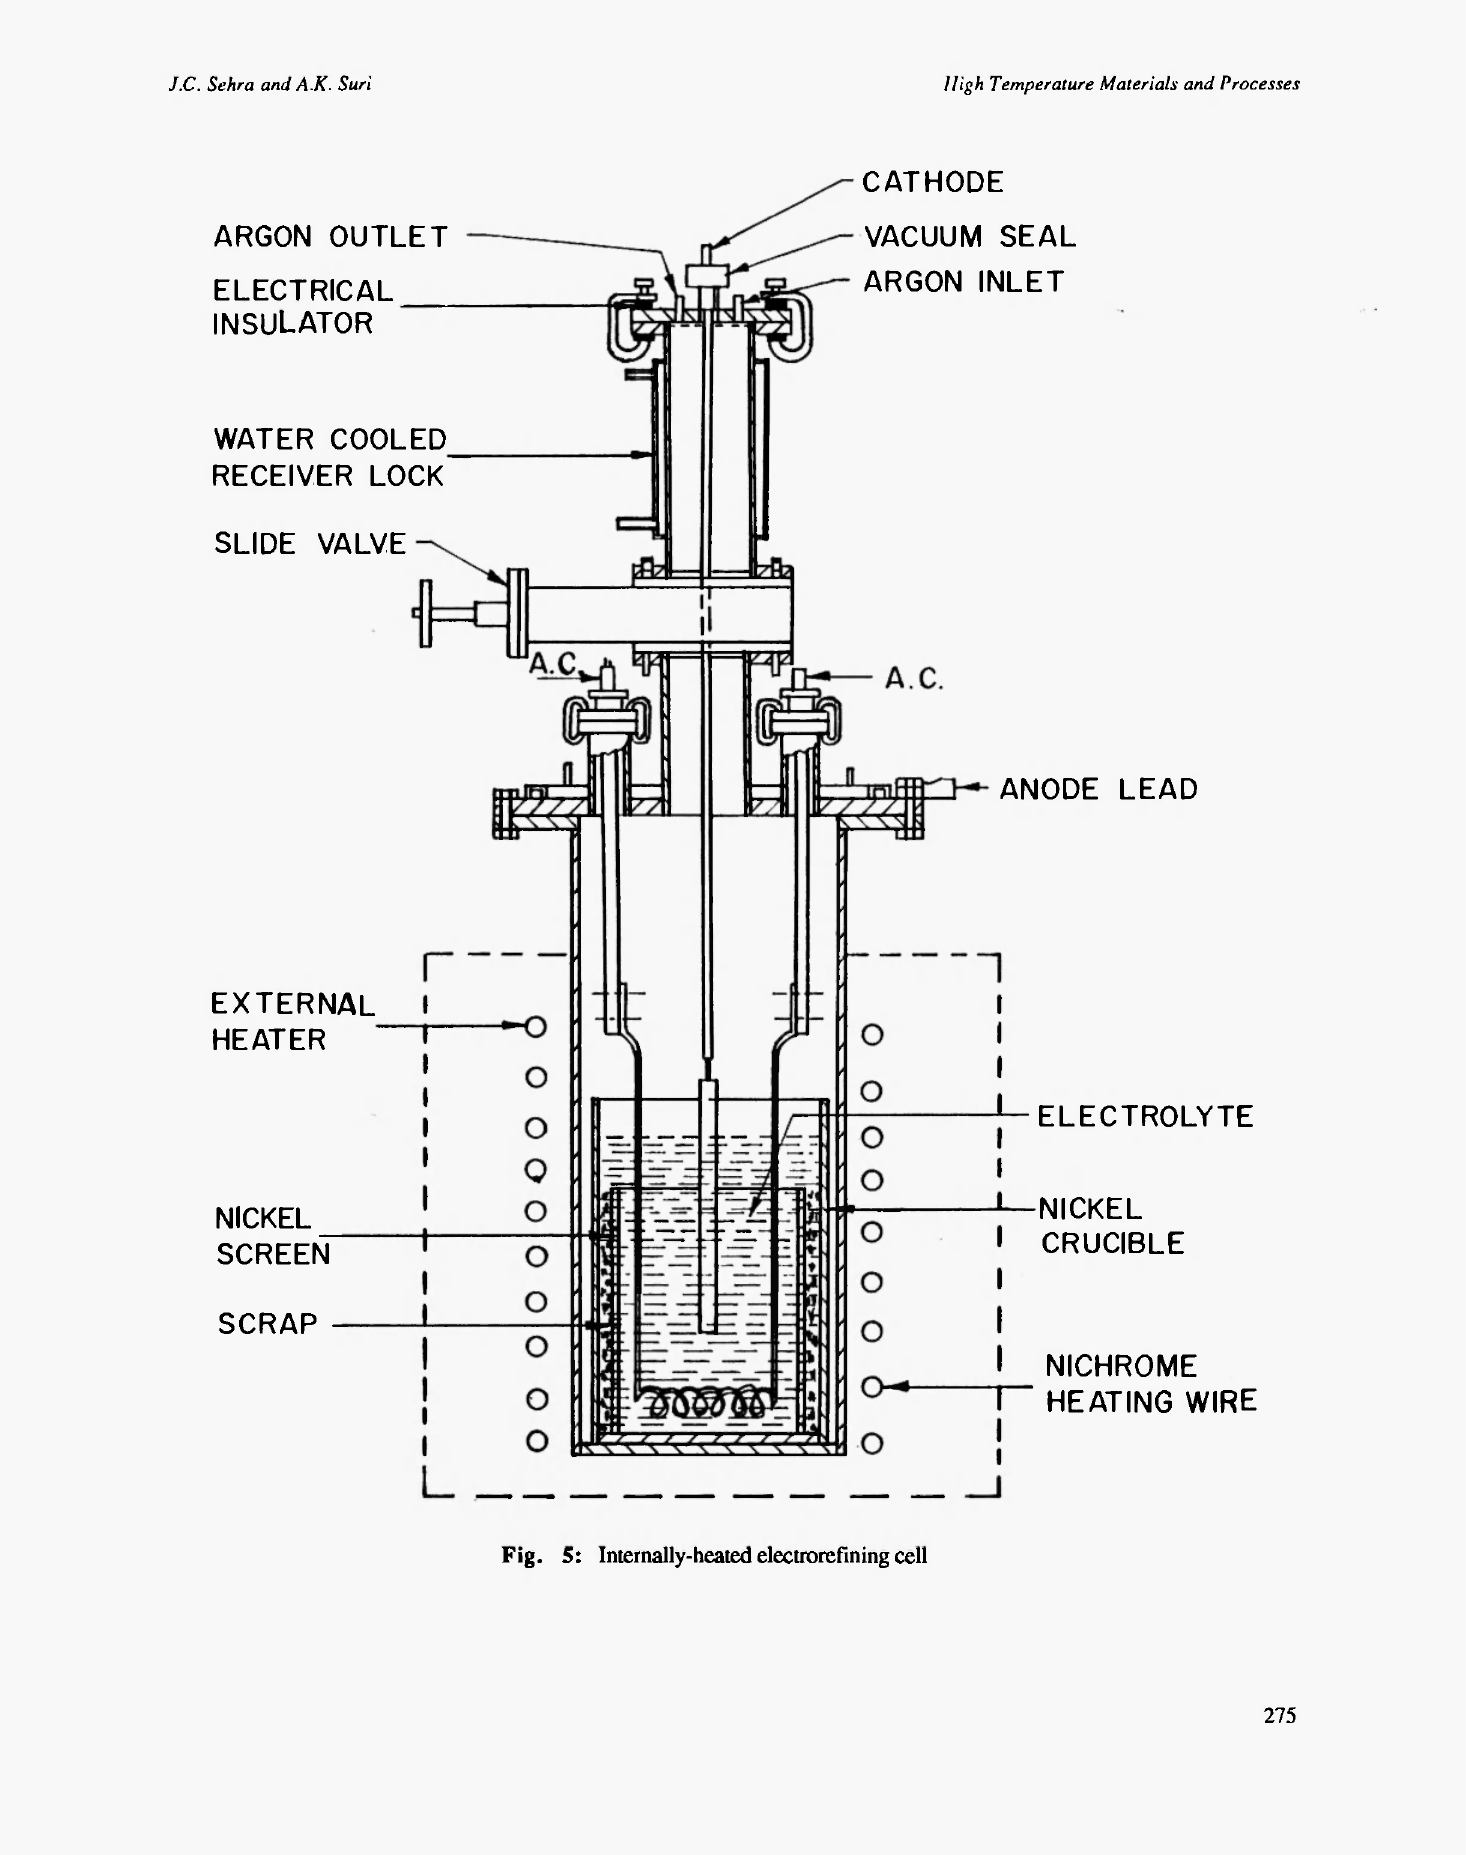
Fig. 5: Internally-heated electrorefining